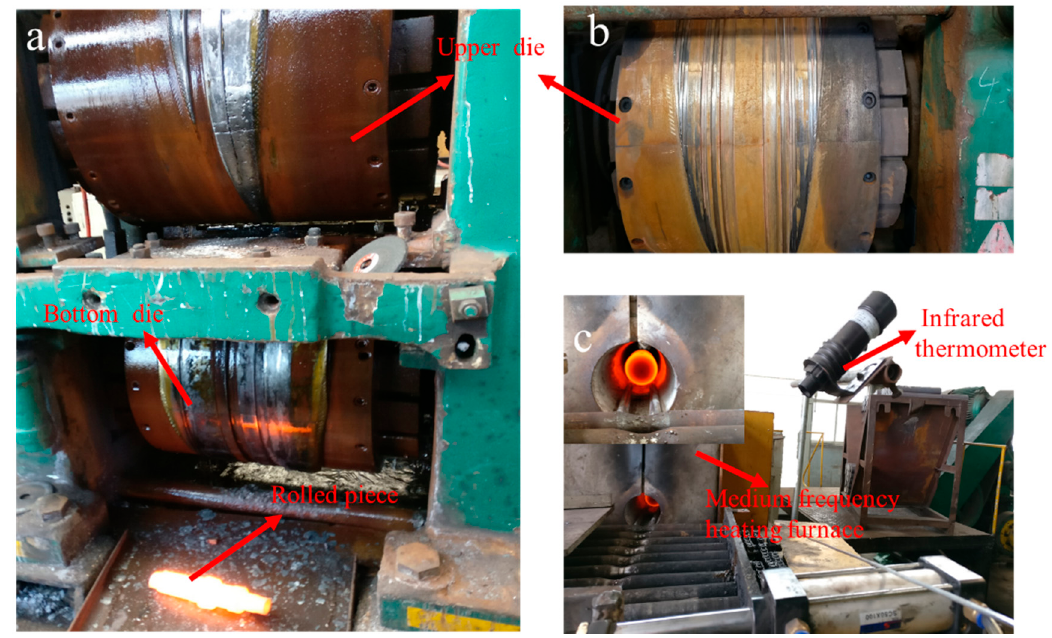
Figure 15. Diagram of the rolling site: ( a ) the H630 type rolling mill; ( b ) the cross-wedge rolling die; ( c ) heating device.